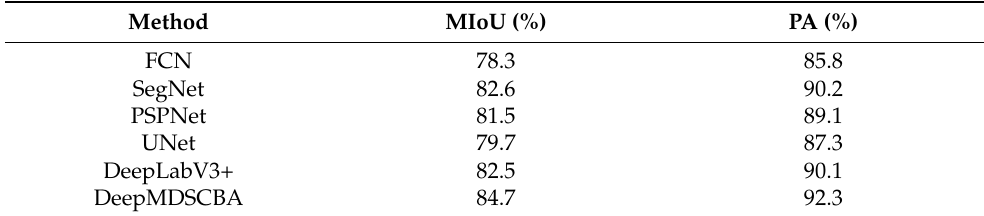
Table 13. Segmentation performance for apple images with an unseen rot position.